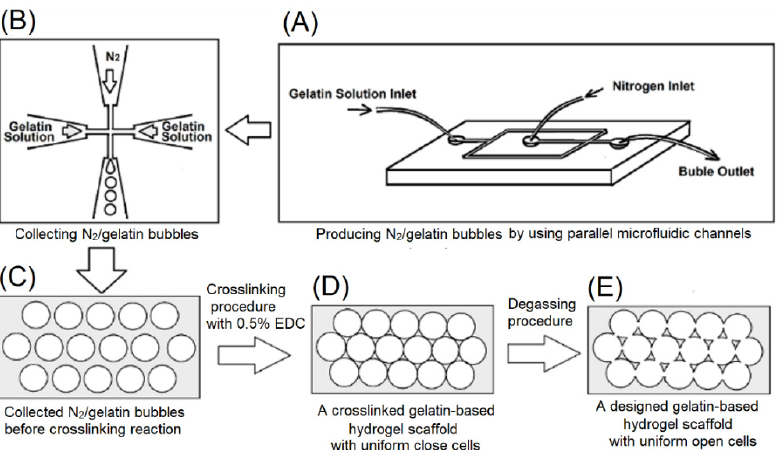
Figure 1. Schematic illustrations for the fabrication process of highly organized EDC-crosslinked porous gelatin-based hydrogel scaffolds, ( A ) producing N 2 /gelatin bubbles by using parallel microfluidic channels, ( B ) collecting N 2 /gelatin bubbles, ( C ) collected N 2 /gelatin bubbles before crosslinking reaction, ( D ) a crosslinked gelatin-based hydrogel scaffold with uniform close cells, and ( E ) a designed gelatin-based hydrogel scaffold with uniform open cells.